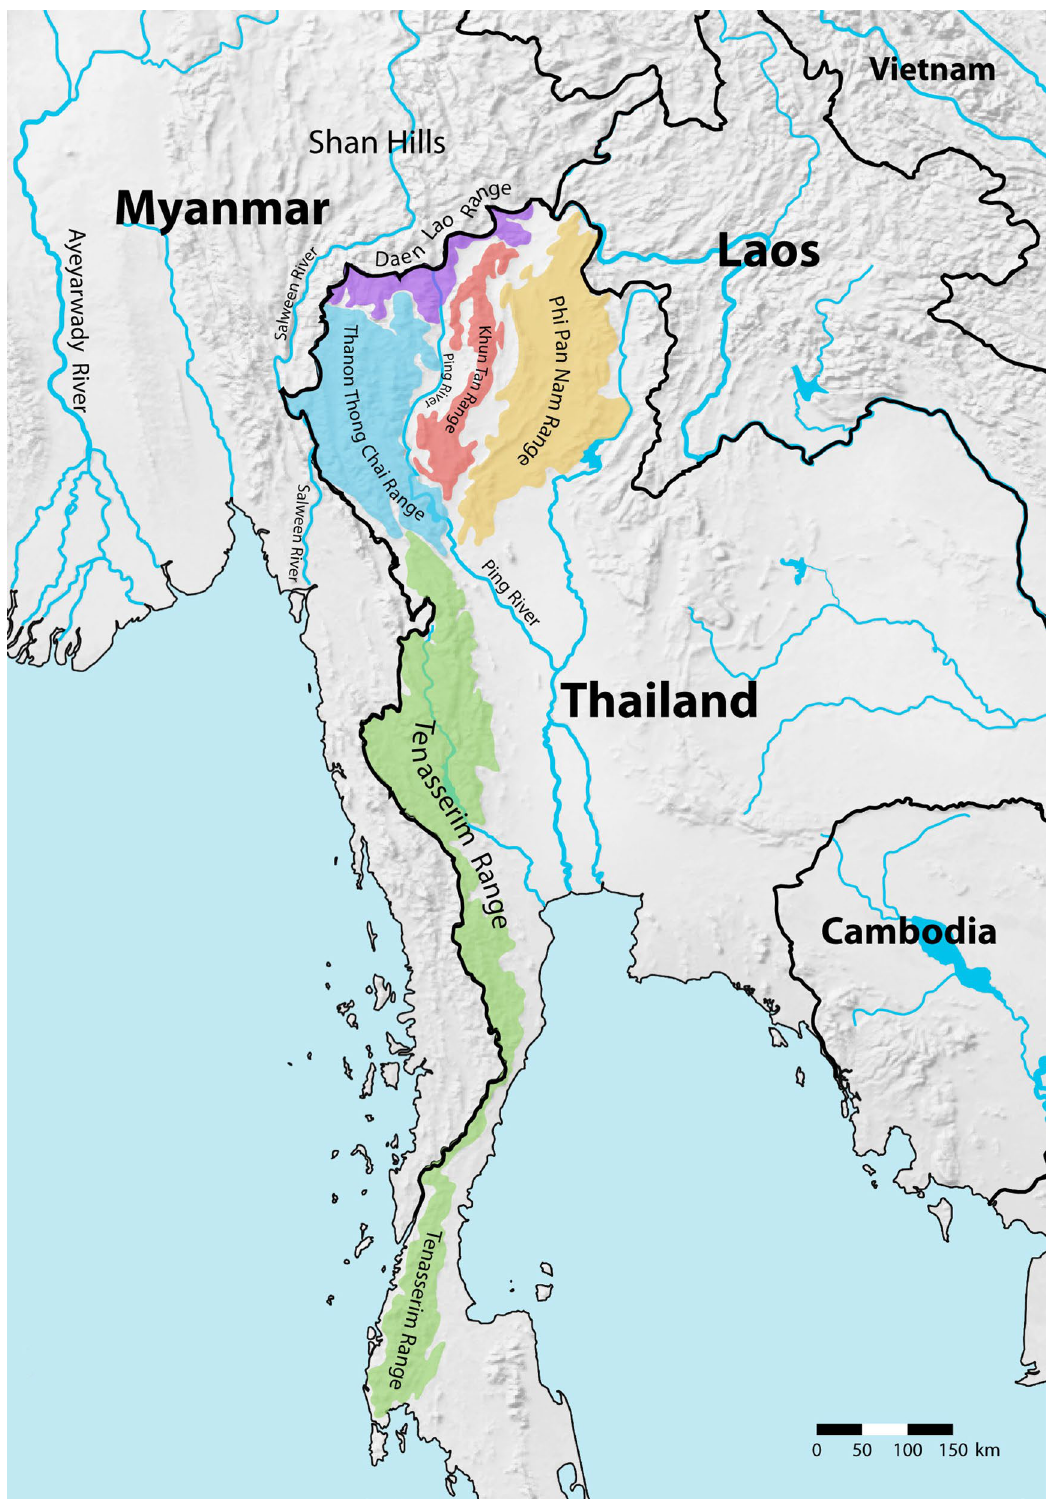
Figure 1. Geography of northern and western Thailand (www.simpl emapp